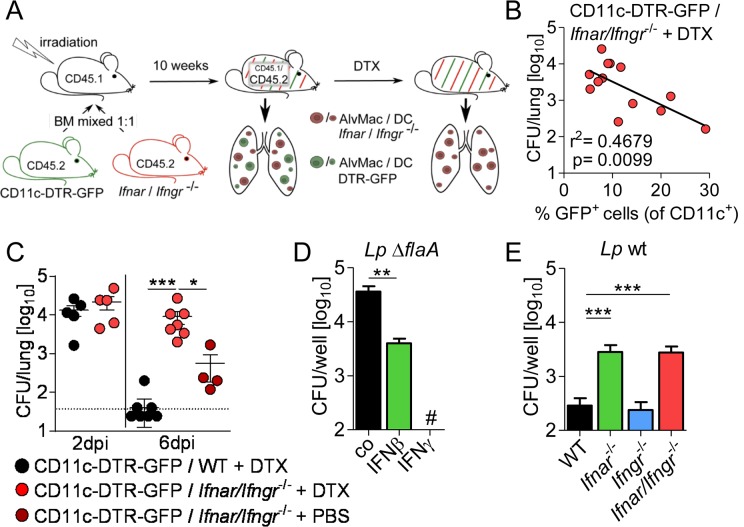
Type I and II IFNs restrict L. pneumophila infection through an alveolar macrophage-intrinsic mechanism.(A) Overview of generation of CD11c-DTR-GFP / Ifnar/Ifngr
-/- mixed bone marrow chimeric mice followed by DTX mediated depletion of CD11c-DTR-GFP+ cells. (B) Frequency of remaining CD11c+ GFP+ wild-type cells was correlated to bacterial load in the lungs of CD11c-DTR-GFP / Ifnar/Ifngr
-/- + DTX chimeras including all DTX-treated mice (13 mice) at 6 d p.i.. (C) Only mice with <10% GFP+ (of all CD11c+ cells) were considered for analysis and bacterial loads in the lungs of L. pneumophila infected mixed bone marrow-chimeric mice at indicated time points are shown. (D, E) Alveolar macrophages of WT, Ifnar
-/-, Ifngr
-/- and Ifnar/Ifngr
-/- mice were left untreated (E) or were treated with 50 U/ml IFNβ or IFNγ (D) 16–18 h prior to and during infection with L. pneumophila ΔflaA (D) or wt (E). Bacterial growth was determined by CFU counting after 72 h. Data represent 3 independent experiments done in triplicates. * p<0.05, ** p<0.01, *** p<0.001 (Pearson correlation (B), Kruskal-Wallis analysis of variance, Dunn’s multiple comparison (C) or Mann-Whitney U test (D, E)). # No bacteria were detected.